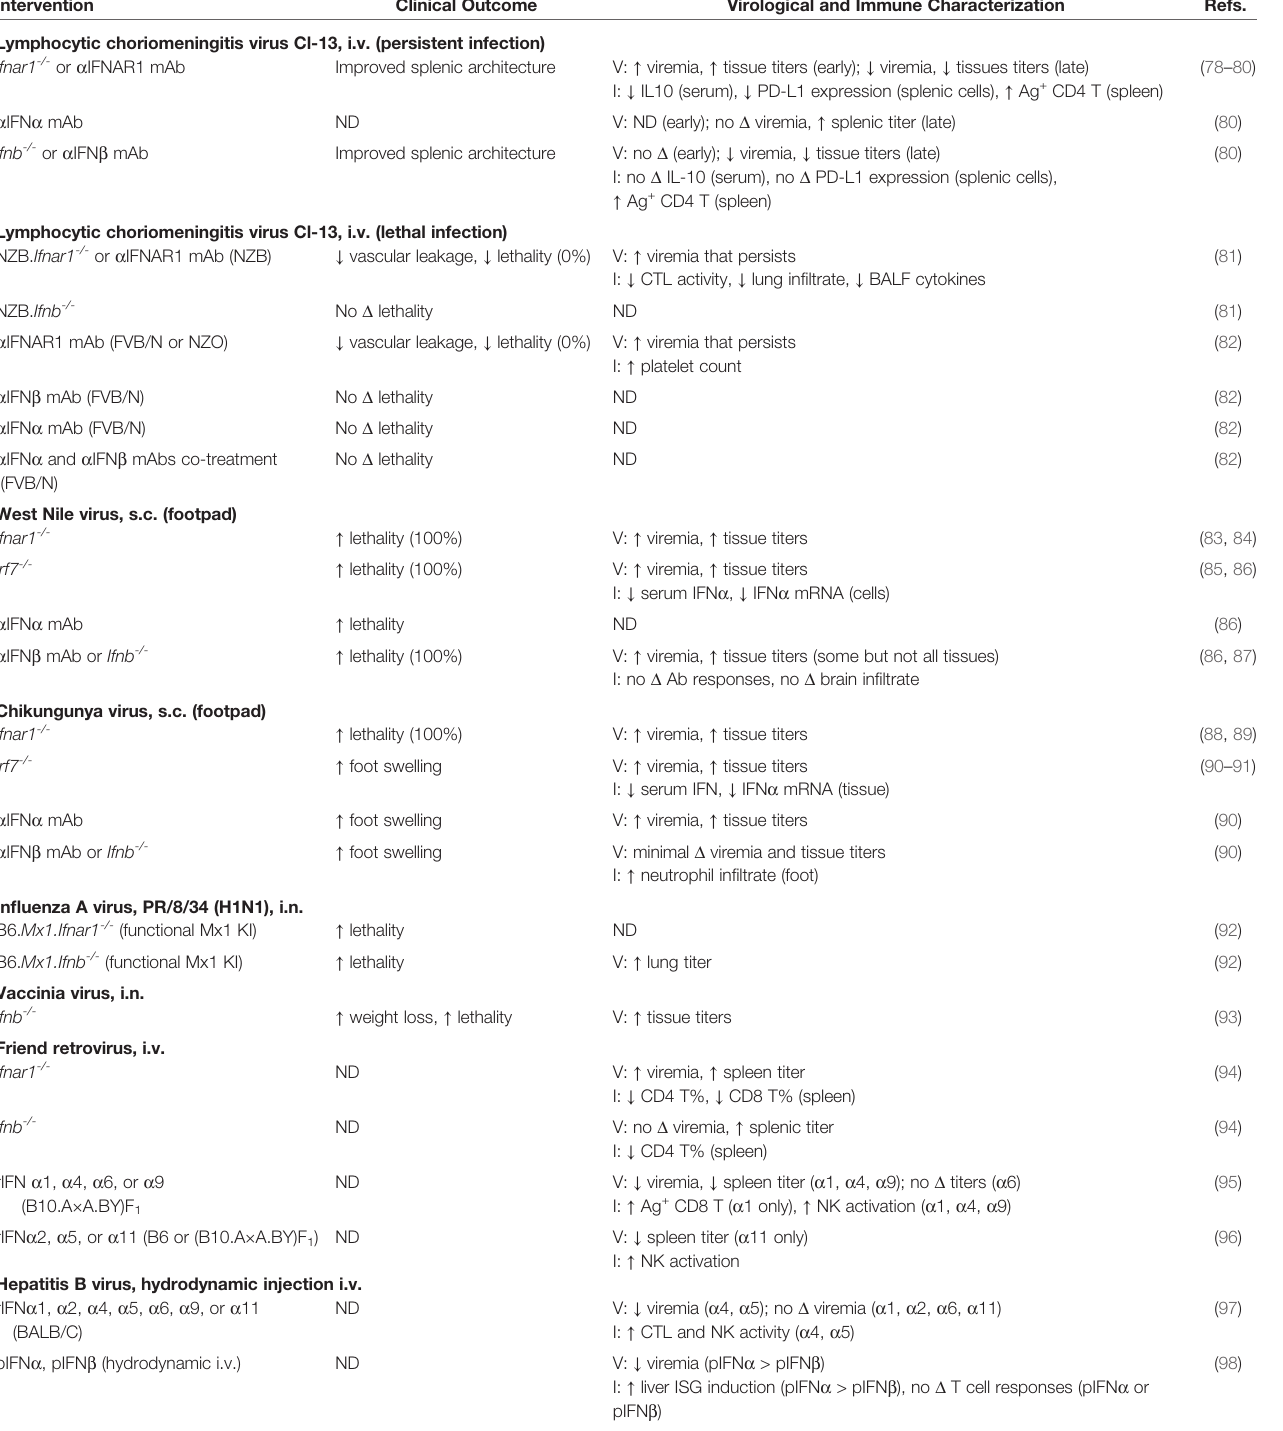
TABLE 1 | Summary of IFN a and IFN b functions in mouse models of viral infections. Intervention Clinical Outcome Virological and Immune Characterization